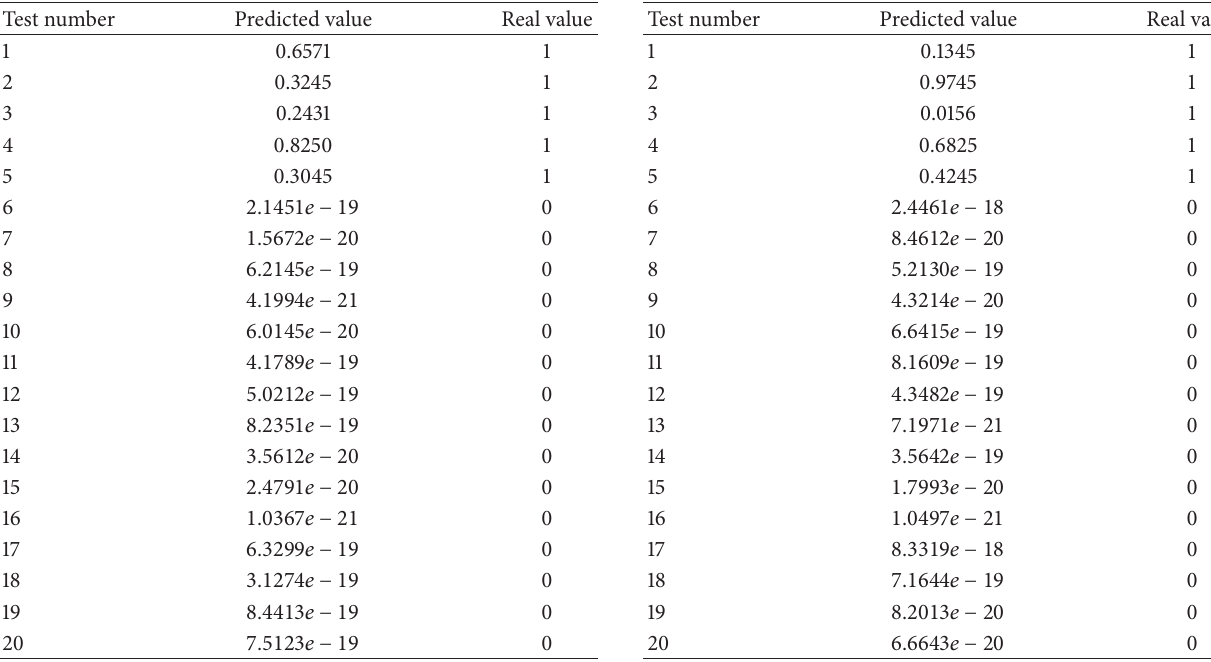
Table 2: The Douglas-2 test results of the RBFNN trained by Douglas-2.